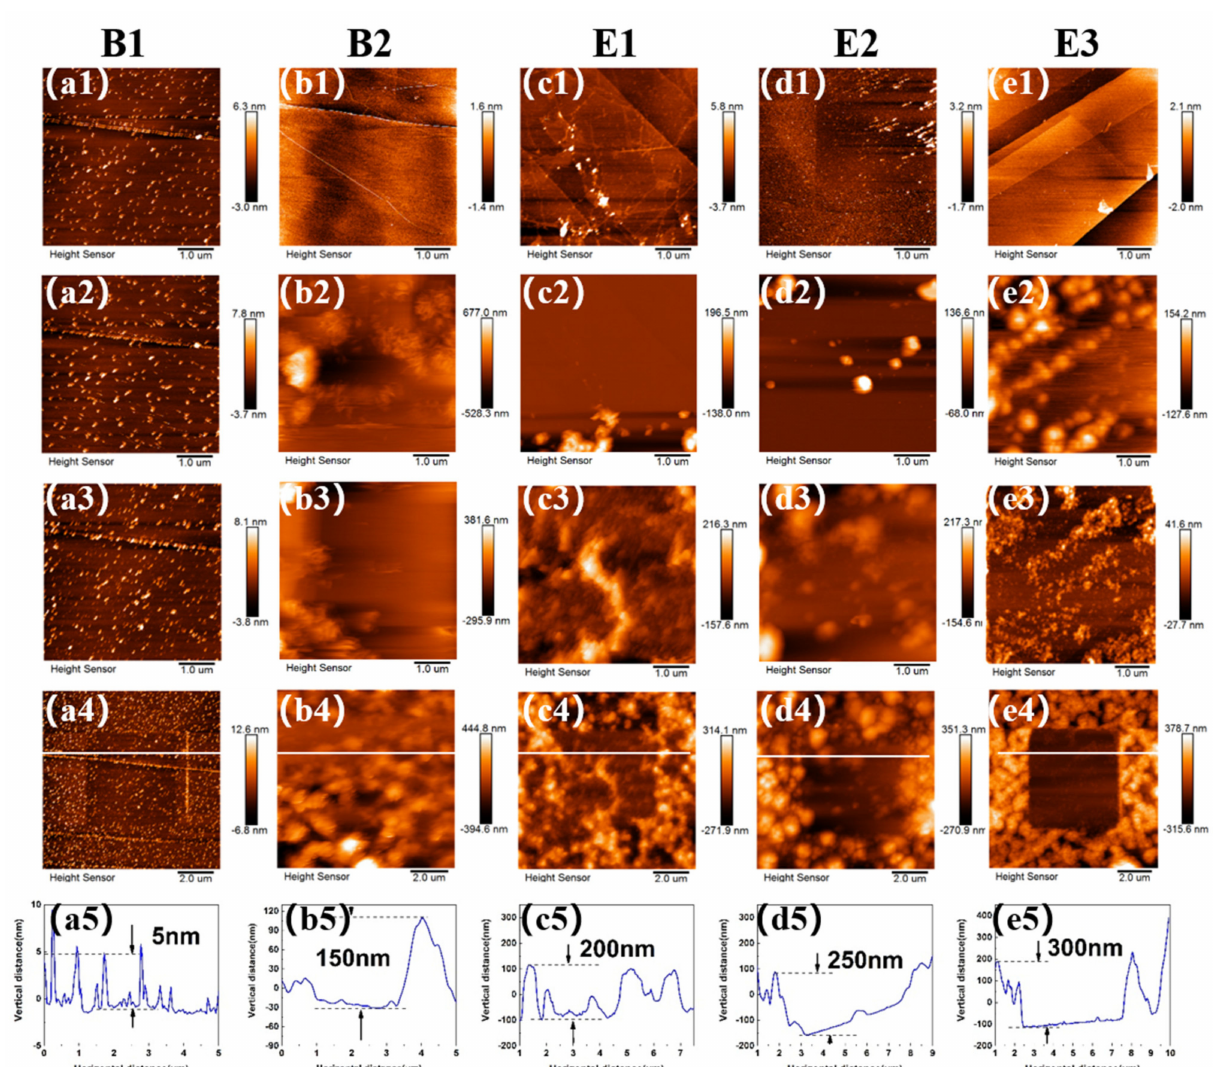
Figure 2. ( a – e ) In situ AFM images of HOPG electrodes in different electrolytes. (First row, a1 – e1 ) HOPG surface before CV cycling, (second row, a2 – e2 ) 2–2.5 V in 1st cycle, (third row, a3 – e3 ) after three cycles of CV, (fourth row, a4 – e4 ) zoomed − out images of the scratched area, (fifth row, a5 – e5 ) line profile analysis of SEI film